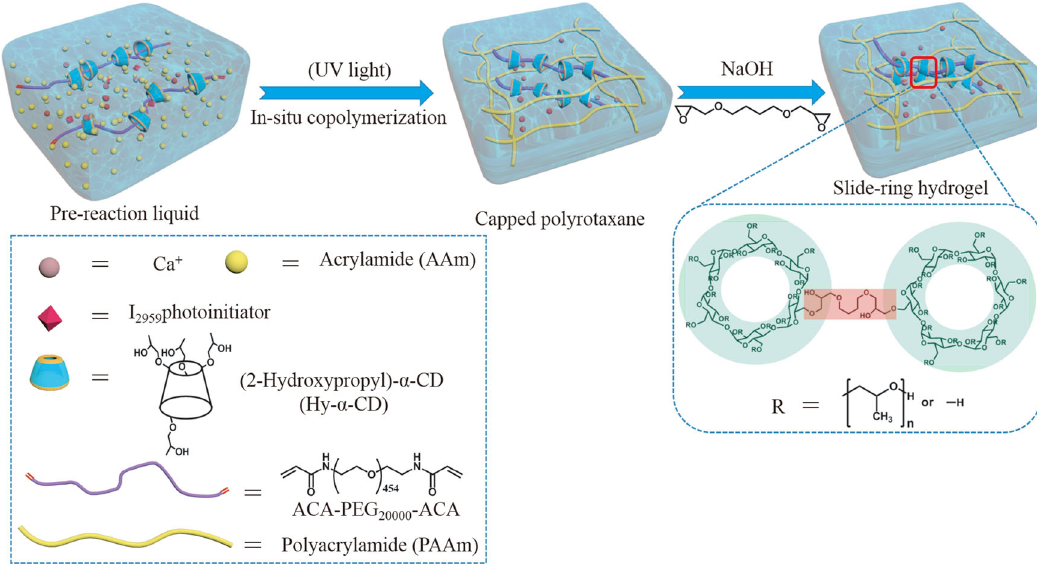
Fig. 1 Schematic illustration. Construction of Hy- α -CD/ACA-PEG 20000 -ACA/Ca hydrogel. (Formation of capped polyrotaxane by photopolymerization; formation of slide-ring hydrogel through further cross-linked cyclodextrins).